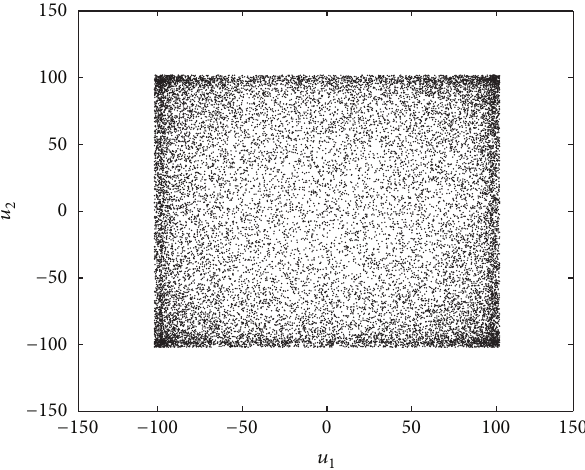
Figure 2: 2D computer simulation result shows complex dynamical behaviors of the controlled system (7) in the (𝑢 1 , 𝑢 2 ) space for 𝛼 = 100 , 𝛽 = 100 𝜋 , 𝑘 = 1 , and 𝑛 from 0 to 20000, with the initial con- dition 𝑢(0) = (0.01, 0.01) 𝑇